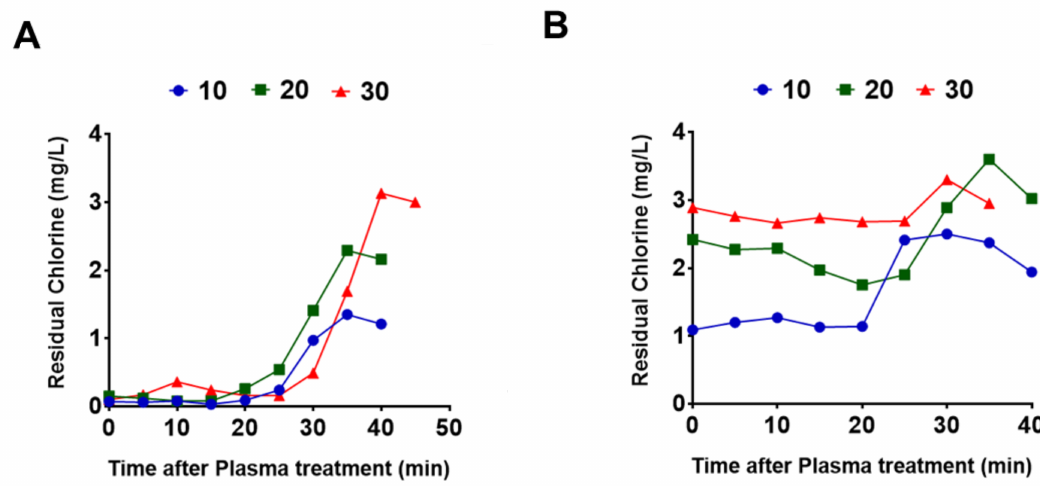
Figure 3. ( A ) Changes in the concentration of free chlorine chemicals in the water after plasma discharge and ( B ) changes in the concentration of chlorine chemicals after secondary plasma